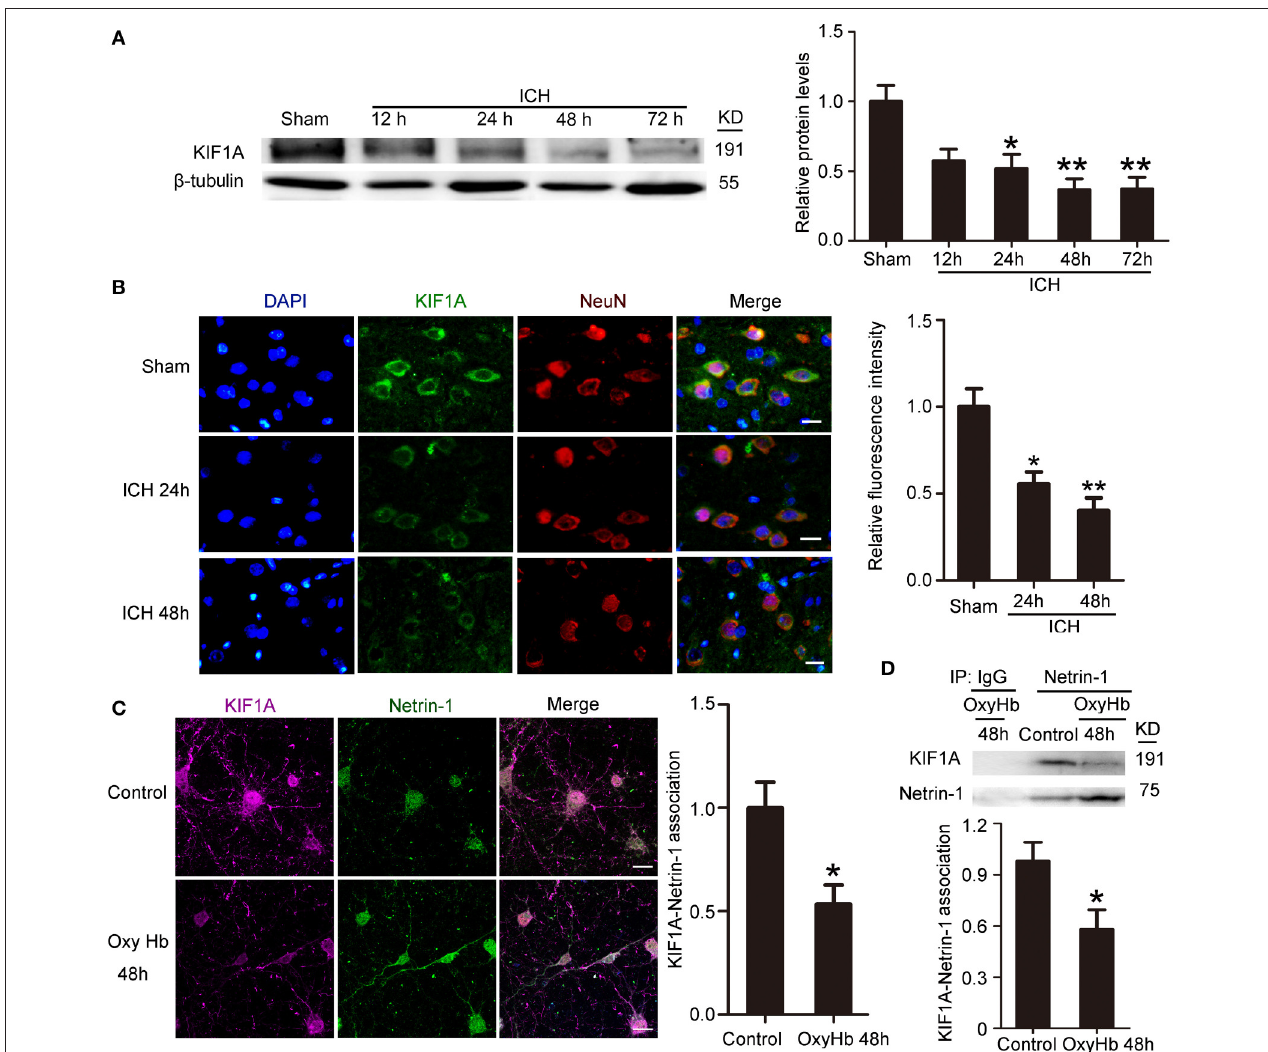
FIGURE 5 | Changes in protein levels and localization of KIF1A after ICH . (A) Western blot assay of KIF1A protein levels in the peri-hematoma cortex at different time points after ICH. All values are expressed as mean ± SEM. Mean values of protein levels in the sham group were normalized to 1.0. * p < 0.05 and ** p < 0.01 vs. the sham group, n = 6. (B) Double immunofluorescence staining was performed with KIF1A antibody (green) and a neuronal marker (NeuN, red), and nuclei were labeled with DAPI (blue). Scale bar = 20 µ m. All values are expressed as mean ± SEM. The mean value of the sham group was normalized to 1.0. * p < 0.05 and ** p < 0.01 vs. the sham group, n = 6. (C) Double immunofluorescence analysis was performed with netrin-1 antibody (green) and KIF1A antibody (purple). Scale bar = 20 µ m. All values are expressed as mean ± SEM. The mean value of the control group was normalized to 1.0. * p < 0.05 vs. the control group, n = 3. (D) KIF1A/netrin-1 interactions in the peri-hematoma cortex were assessed by a co-immunoprecipitation assay. Quantitative histogram analysis was performed. All values are expressed as mean ± SEM. * p < 0.05 vs. the control group, n =